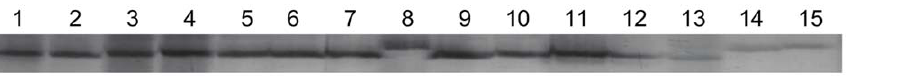
Figure 4. Electrophoresis pattern of 15 materials at SSR marker umc1216 locus of an endosperm modifier. 1, Taixi 19; 2, QCL 3021; 3, QCL 5019; 4, CML171; 5, (Taixi19 6 QCL 3021)F 1 ; 6, (QCL 5019 6 QCL3021)F 1 ; 7, (QCL 5019 6 Taixi 19)F 1 ; 8, Nanbeinuo; 9, G122; 10, G261; 11, G67; 12, G134; 13, CML162; 14, CML193; 15, QCL2179.